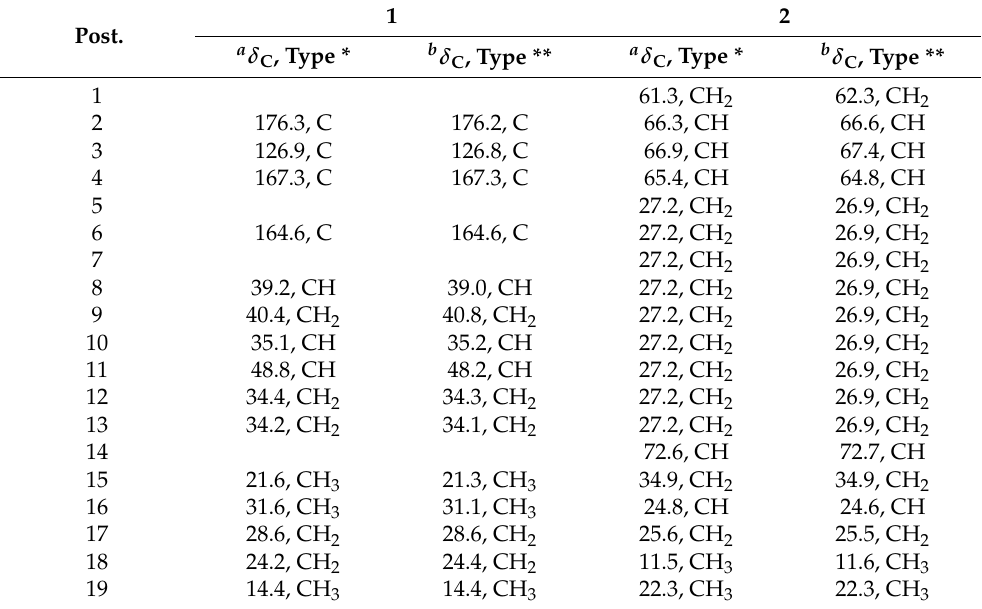
Table 9. Experimental a and reported b 13 C NMR (125 MHz) data for mirabilin B ( 1 ) and penaresidin B ( 2 ).